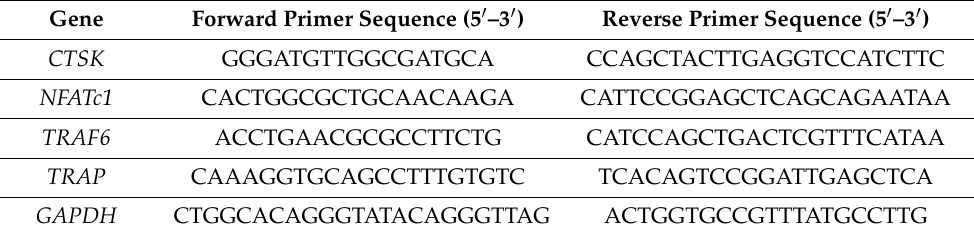
Table 1. qPCR forward and reverse primer sequences. The annealing procedures were performed at 60 ◦ C for all